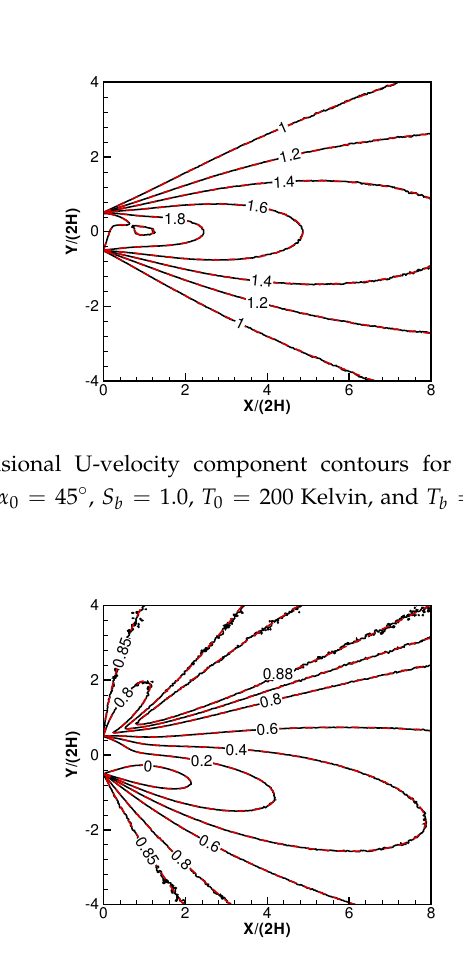
Figure 5. Nondimensional V-velocity component contours for the jet/background mixture, n b / n 0 = 0.2, S 0 = 2.0, α 0 = 45 ◦ , S b = 1.0, T 0 = 200 Kelvin, and T b = 300 Kelvin. Red: analytical, black: